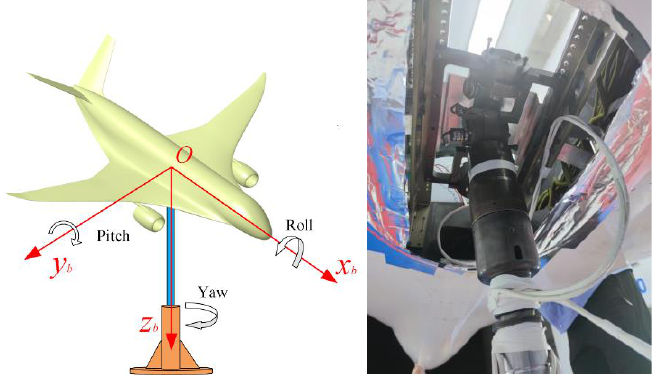
Figure 1. The 3-DOF wind tunnel virtual flight test. Figure 1. The 3‑DOF wind tunnel virtual flight